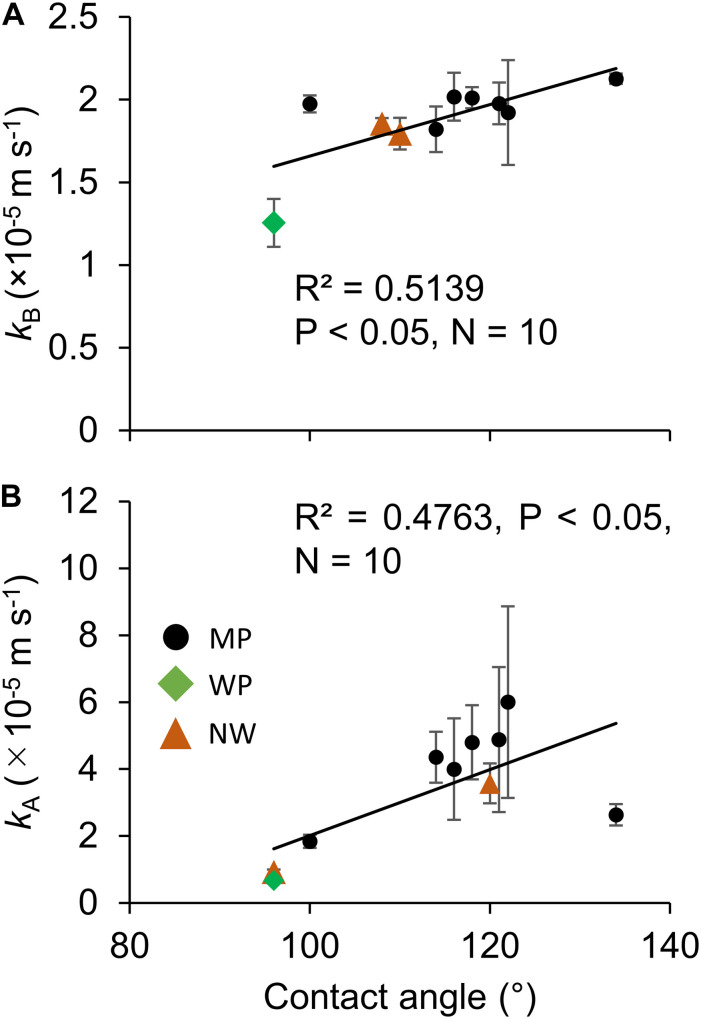
The effect of hydrophobicity (contact angle) on the oxygen transfer coefficients in (A) Room B and (B) Room A. N = 3 for all the 10 microporous membranes measured in this study. The error bar shows the standard deviation. MP: microporous; WP: woven porous; and NW: microporous with a non-woven fabric.